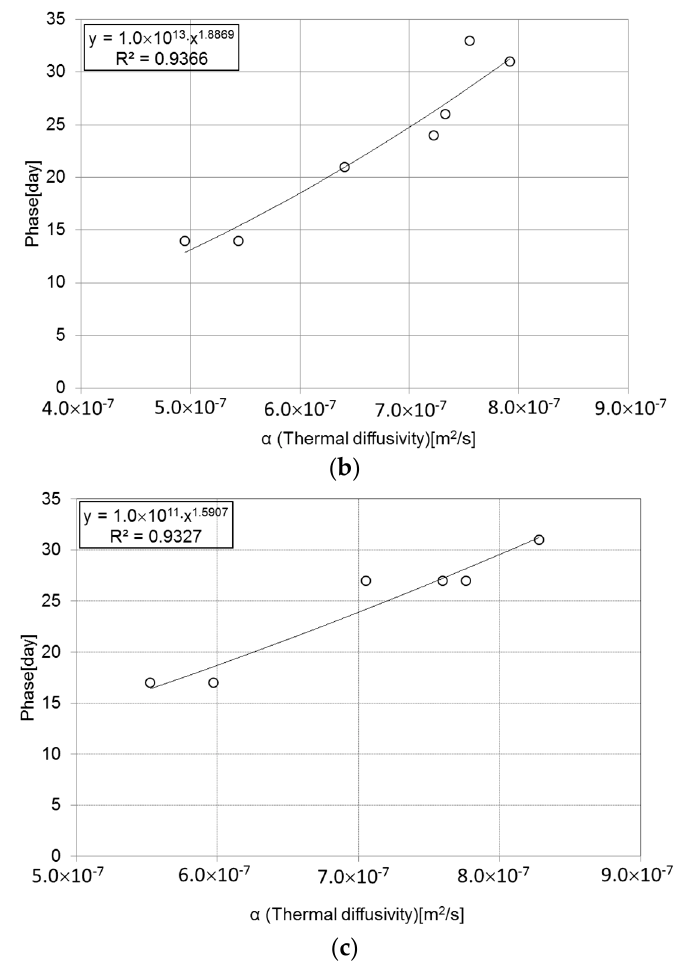
Figure 4. Regression analysis to determine phase lag of ground surface temperature wave ( 𝑡 (cid:3042) ) at underground depth: ( a ) phase lag ( 𝑡 (cid:3042),(cid:2869)(cid:3040) ) at underground depth of 1 m; ( b ) phase lag ( 𝑡 (cid:3042),(cid:2871)(cid:3040) ) at underground depth: ( a ) phase lag ( t o ,1 m ) at underground depth of 1 m; ( b ) phase lag ( t o ,3 m ) at underground depth of 3 m; ( c ) phase lag ( 𝑡 (cid:3042),(cid:2873)(cid:3040) ) at underground depth of 5 m. underground depth of 3 m; ( c ) phase lag ( t o ,5 m ) at underground depth of 5